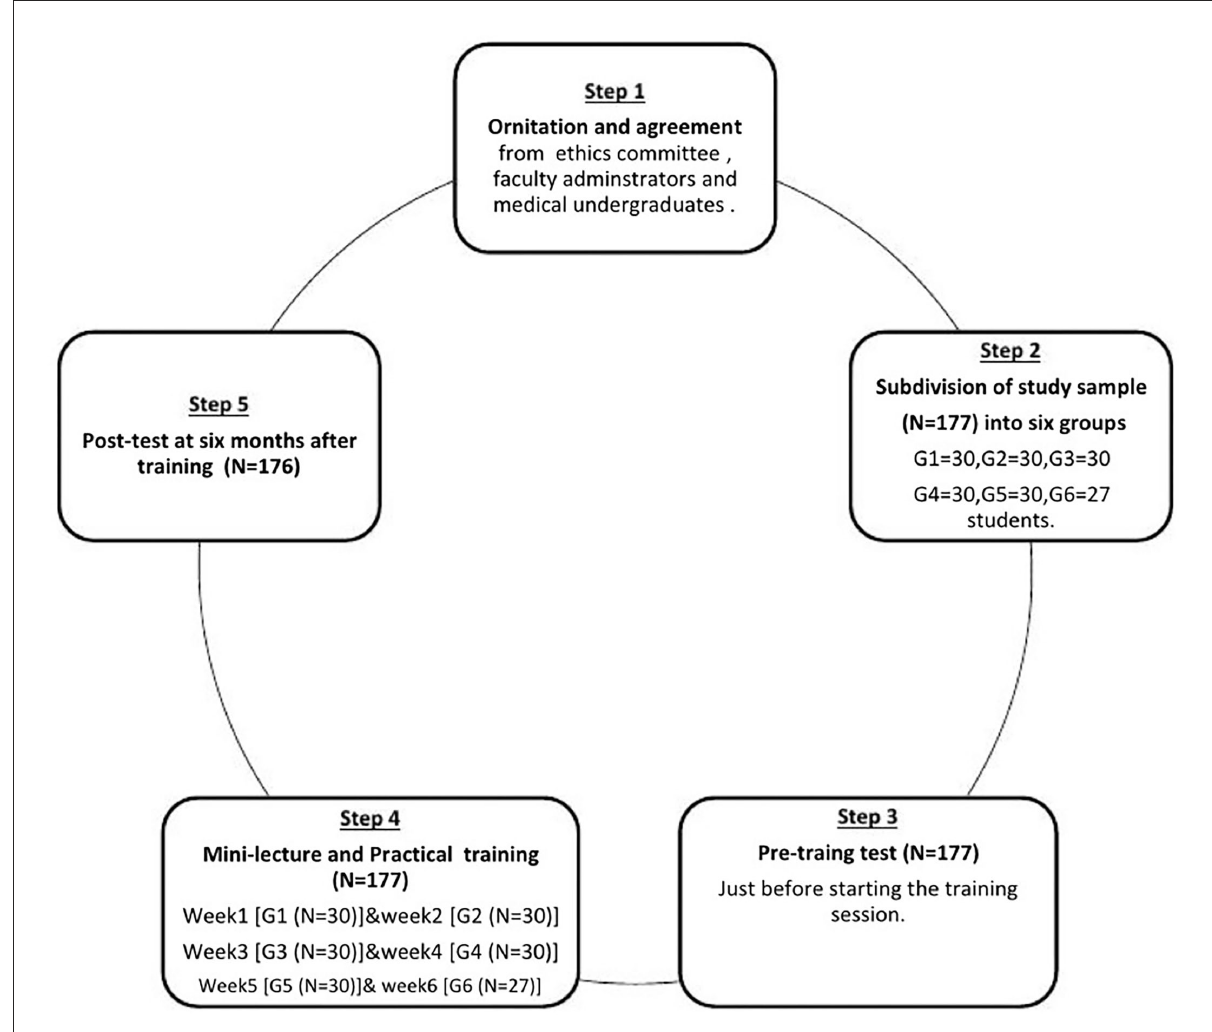
FIGURE1 A framework of the study phases scheme.